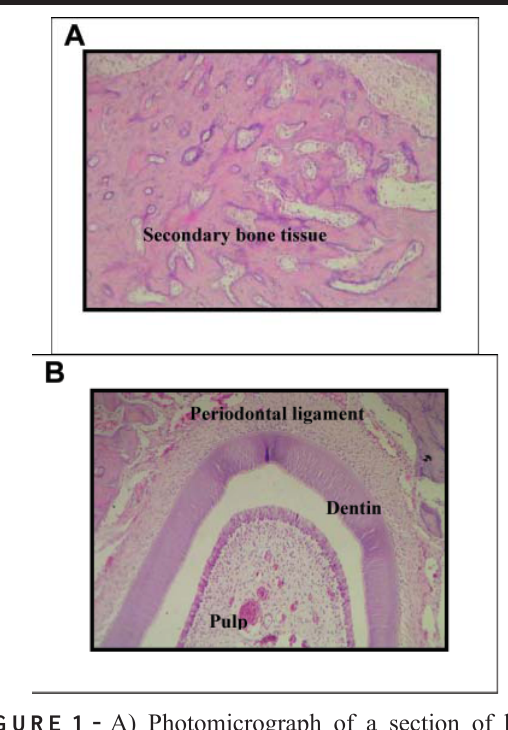
FIGURE 1 - A) Photomicrograph of a section of bone tissue of a mandible with harversian system, without tumor. HE 100X. B) Molar tooth showing dentin, pulp and periodontal ligament. HE 100X.